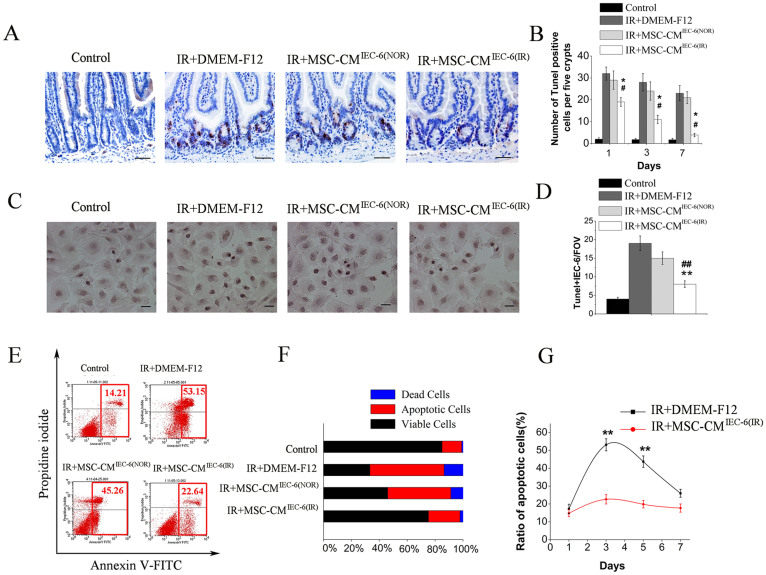
MSC-CMIEC-6(IR) reduces apoptosis of intestinal epithelial cells after radiation in vivo and in vitro.(A) Apoptosis was assayed by TUNEL staining 3 days after irradiation. Scale bars 50 μm. (B) Quantification of TUNEL-positive cells. n = 3 in each group. The number of positive cells in 5 crypts was scored in 100 crypts per section and reported as mean ± SD. *, P < 0.05 versus IR + DMEM-F12, #, P < 0.05 versus IR + MSC-CMIEC-6(NOR). (C) Apoptosis of irradiated IEC-6 was assayed by TUNEL staining 3 days after radiation. Scale bars 25 μm. (D) Quantification of TUNEL-positive IEC-6 cells. Data are reported as means ± SD for 10 random fields per wells from four replicate wells per group. **, P < 0.05 versus IR + DMEM-F12, ##, P < 0.05 versus IR + MSC-CMIEC-6(NOR). FOV, field of view. (E) Apoptosis and cell death of IEC-6 were evaluated quantitatively by flow cytometry after PI/Annexin V staining. The right lower quadrant (RLQ) contains early apoptotic cells, and the upper right quadrant (RUQ) contains late apoptotic and necrotic cells. The proportions of cells in RLQ + RUQ were as follows: Control: 14.21%; IR + DMEM-F12: 53.15%; IR + MSC-CMIEC-6(NOR): 45.26%; IR + MSC-CMIEC-6(IR): 22.64%. (F) The percentage of total apoptotic cells and dead cells under each condition from panel E are shown. (G) The ratio of apoptosis IEC-6 cells was determined by PI/Annexin V staining at 1, 3, 5, 7 days after radiation. Data represent means ± SD of three independent experiments. **, P < 0.05 versus IR + DMEM-F12.